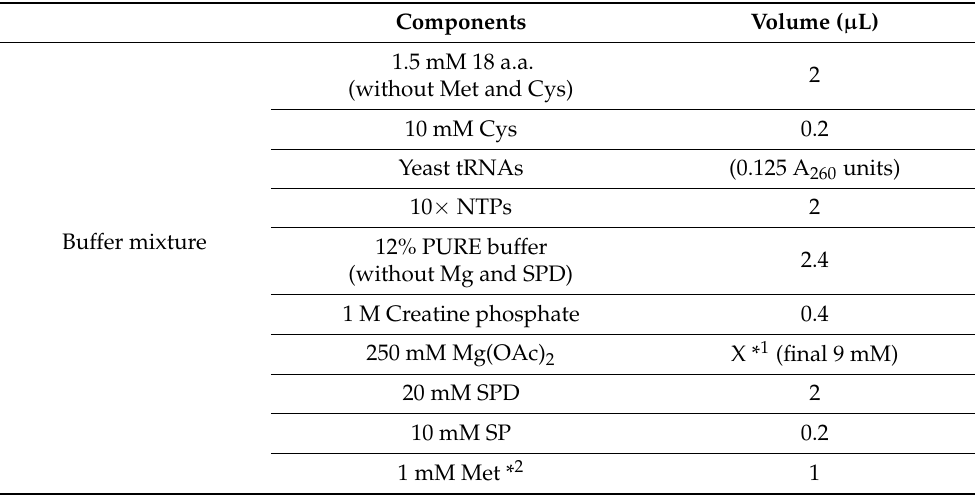
Table 2. Components in the “Transcription-Aminoacylation-Translation Coupled